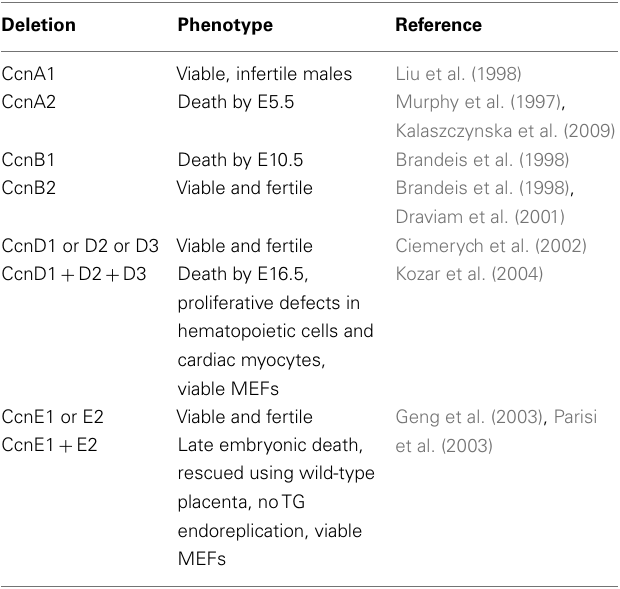
Table 3 | Effect of cyclin deletions on mouse